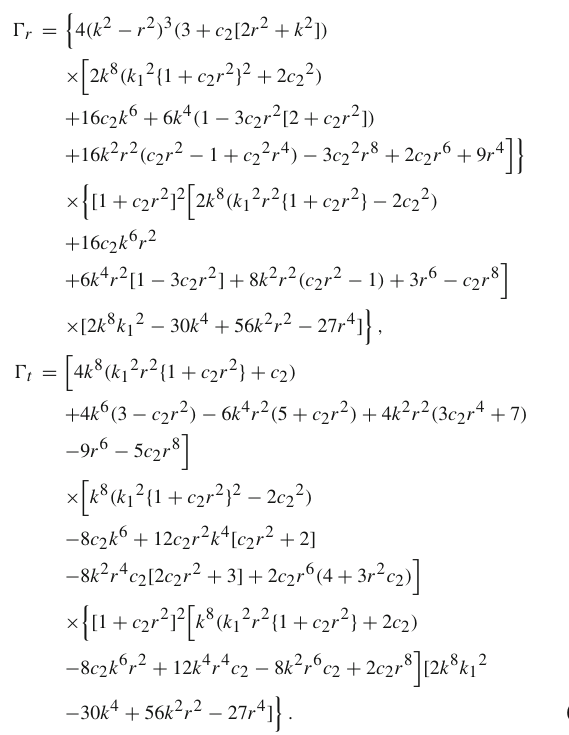
Fig. 12 Plot of the gravitational, the anisotropic, the hydrostatic and the electromagnetic forces versus the radius r using the constants con- strained from PSR J 1614-2230